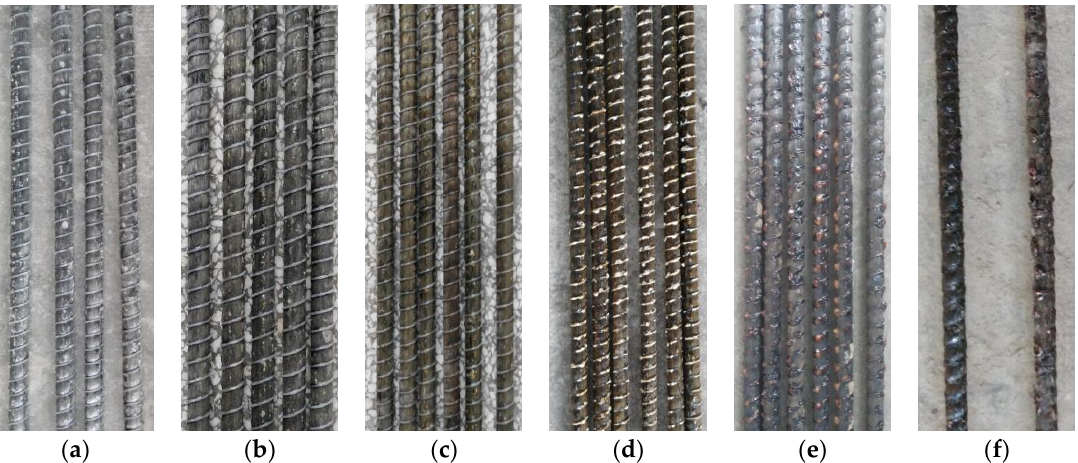
Figure 1. Appearances of GFRP bars after elevated temperatures exposure: ( a ) at 100 °C and holding time of 2 h; ( b ) at 150 °C and holding time of 0 h; ( c ) at 200 °C and holding time of 2 h; ( d ) at 250 °C and holding time of 0 h; ( e ) at 300 °C and holding time of 1 h; ( f ) at 350 °C and holding time of 0 h.